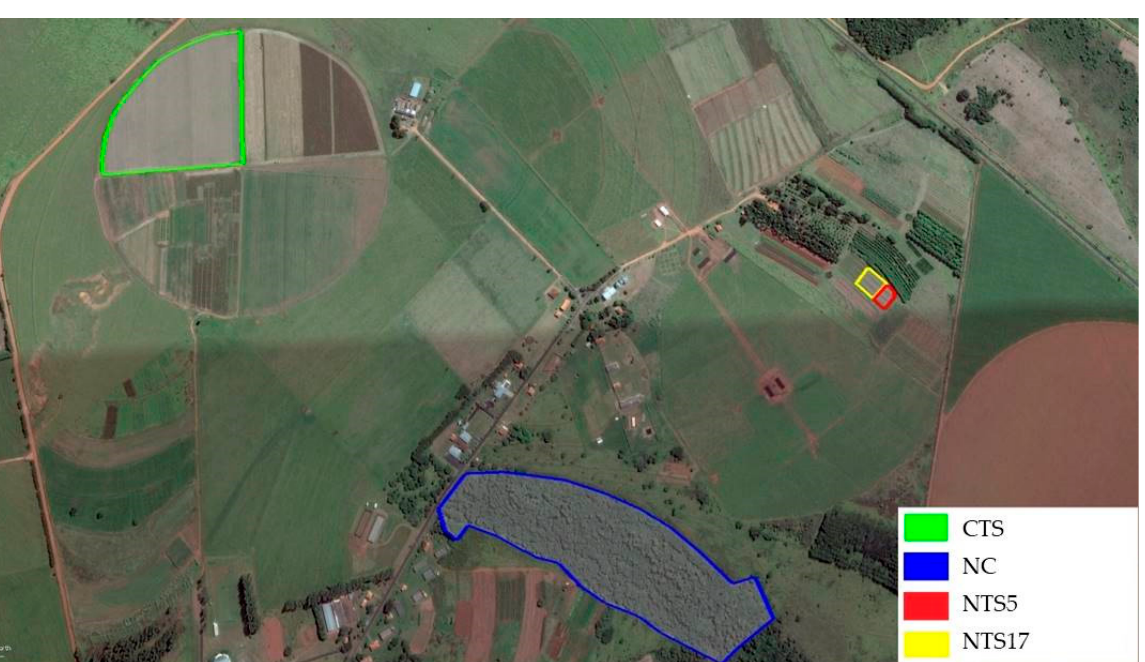
1995.3 mm, well above what is normal for the region (Figure 2)